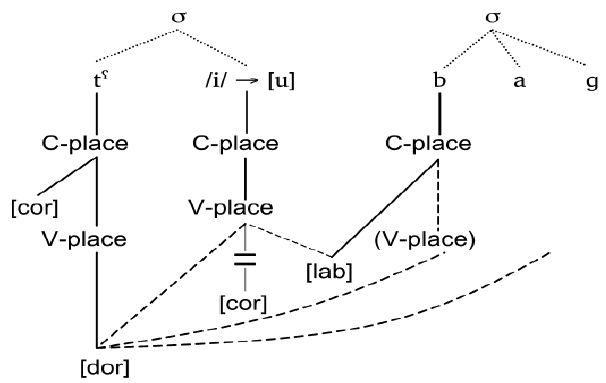
/ Tibag / to [Tubag] (Youssef 2015, p. Figure 8. The change from /Tibag/ to [Tubag] (Youssef 2015, p. 82). Figure 8. The change from